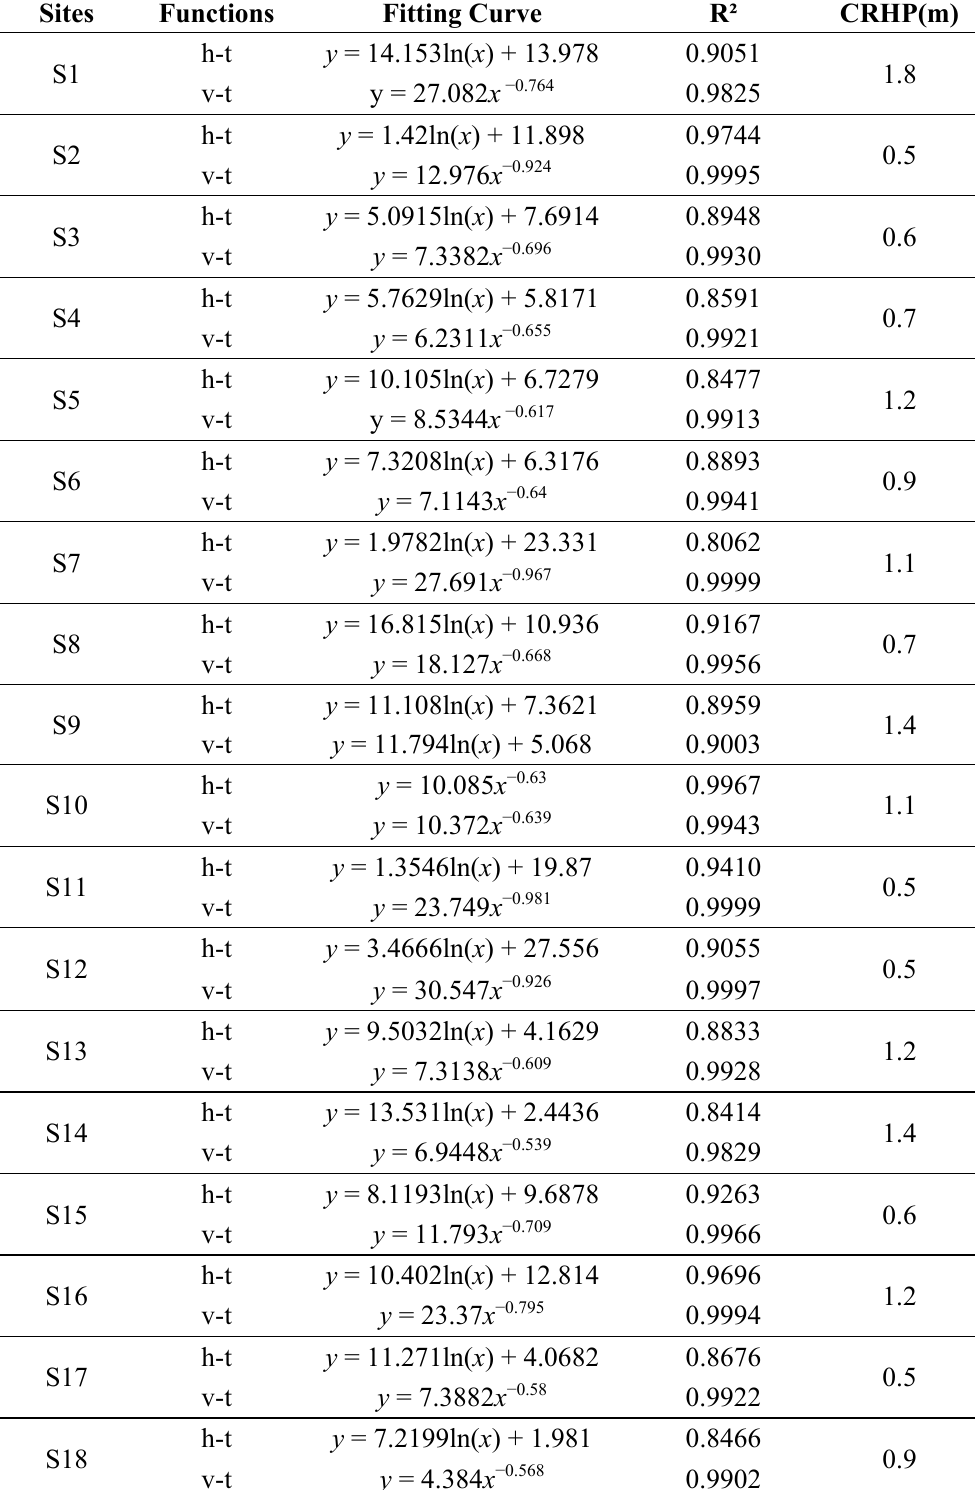
Table 3. Capillary rise heights of phreatic surface (CRHP) on the Sanjiang Plain, Northeast China, and the regressions used for their